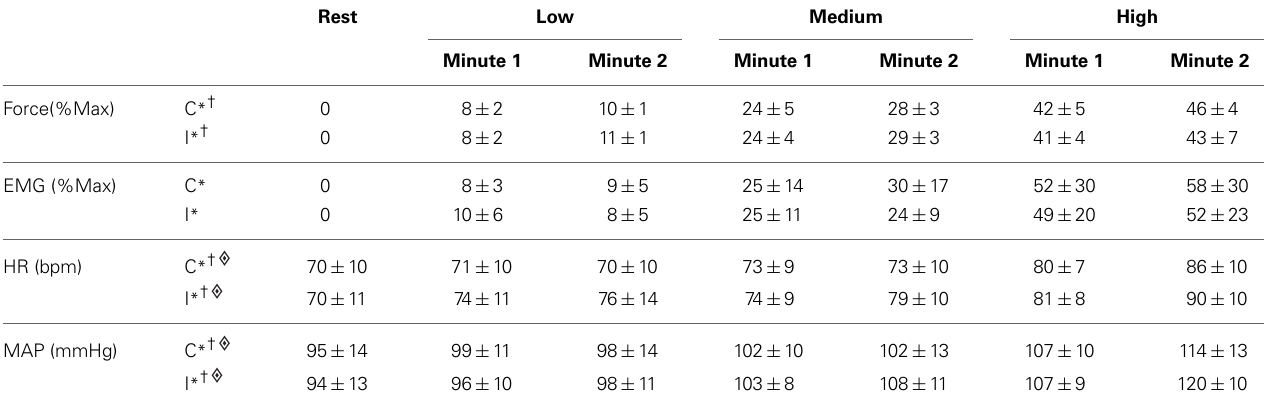
Table 1 | Force, EMG, heart rate (HR), and mean arterial pressure (MAP) responses during the first and second minute of contractions at three intensities (low, medium, high) under control (C) and ischemic (I) conditions.